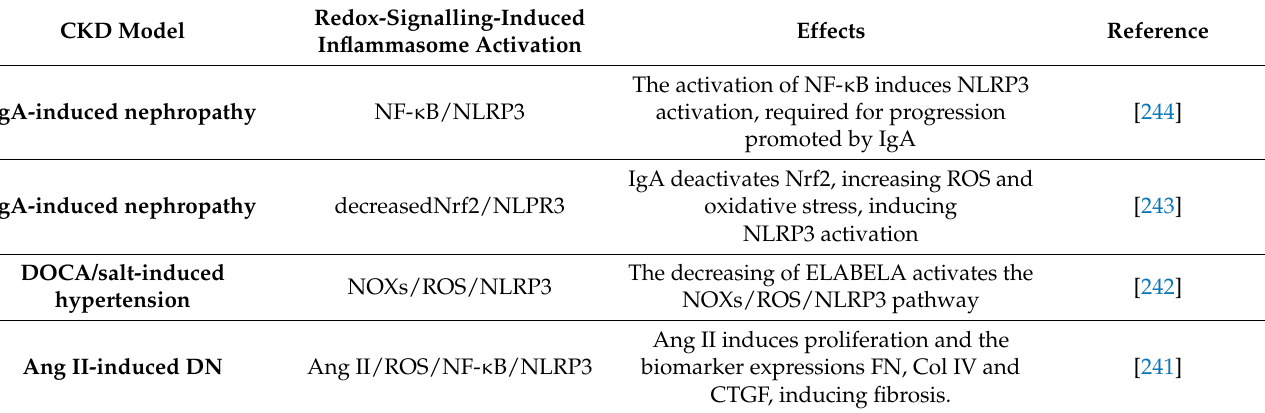
Table 5. Redox-signalling pathway-induced inflammasome activation in